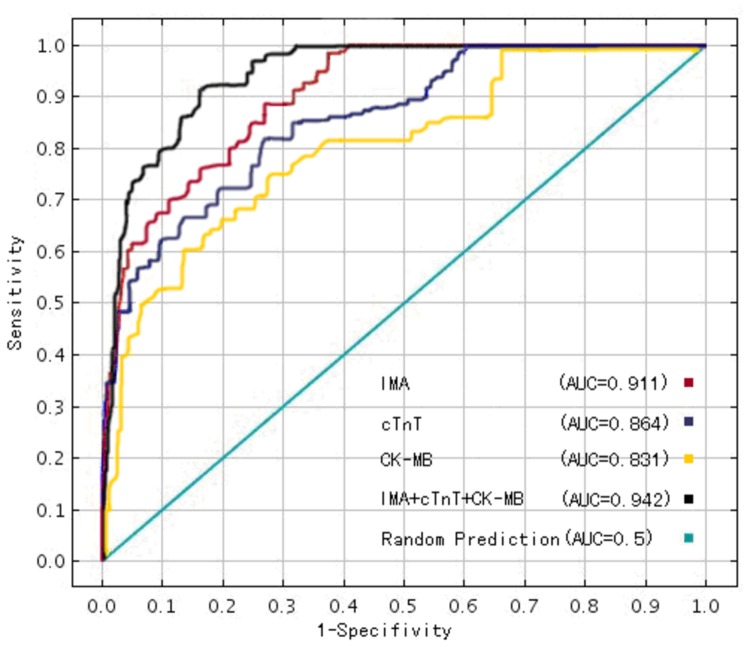
ROC curves analysis of IMA, cTnT, CK-MB, and IMA + cTnT + CK-MB.ROC analysis included 136 patients with no myocardial injury as a negative group and 16 patients with myocardial injury as a positive group. Receiver Operating Characteristic curves: ROC curves; AUC: area under the ROC curves.